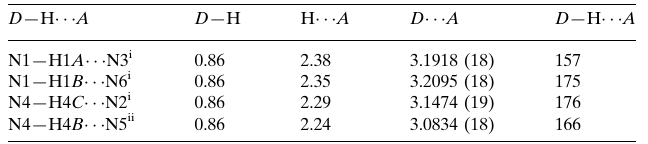
Hydrogen-bond geometry (A˚ , (cid:1)